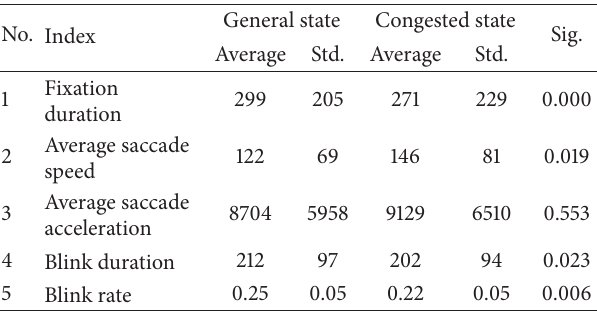
Table 7: Difference significance for the indicators of drivers’ visual